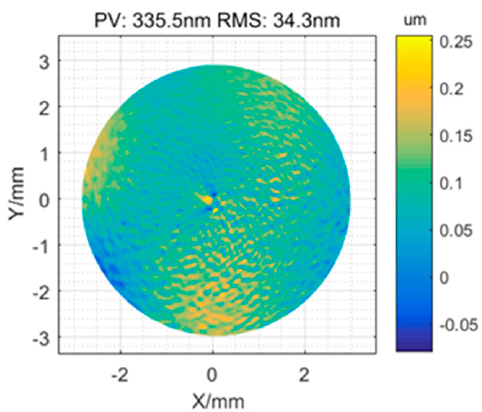
Figure 8. Form error of freeform surface after third compensation.